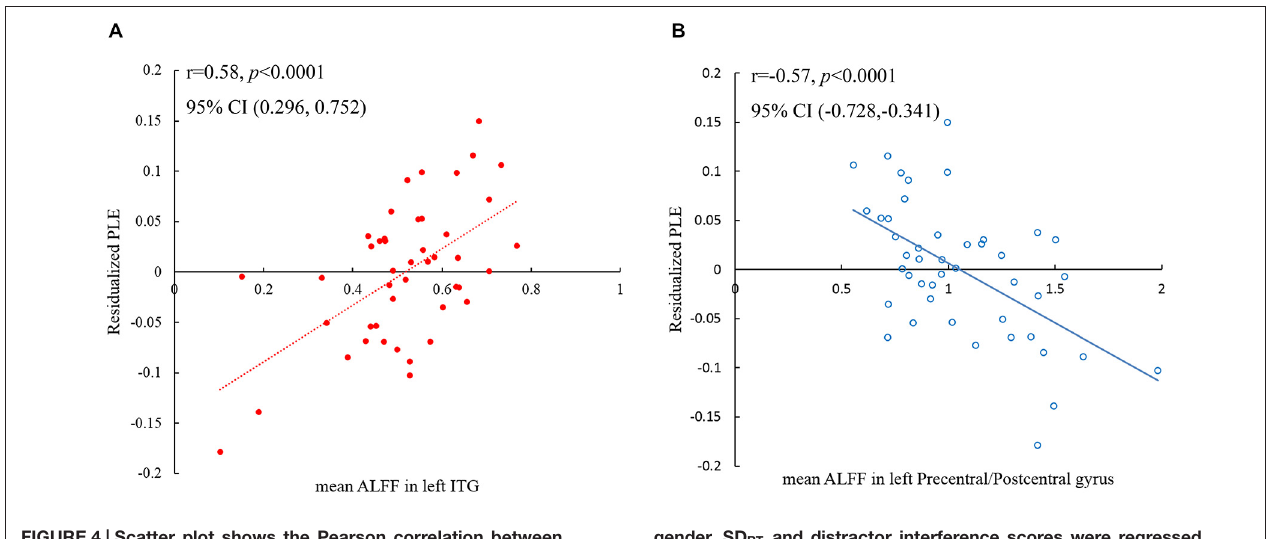
gender, SD RT and distractor interference scores were regressed out from the PLE scores. Each dot in (A) and each circle in (B) represents data from one